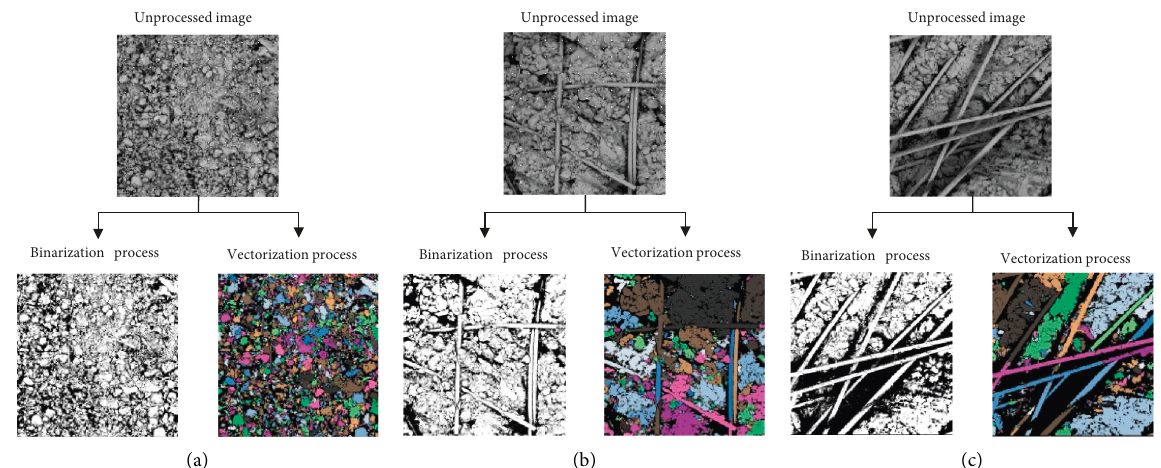
Figure 12: Binarized and vectorized images of improved loess with different ratios of glass fiber (a) 0% plain soli (b) 0.6% incorporation ratio (c) 0.8% incorporation